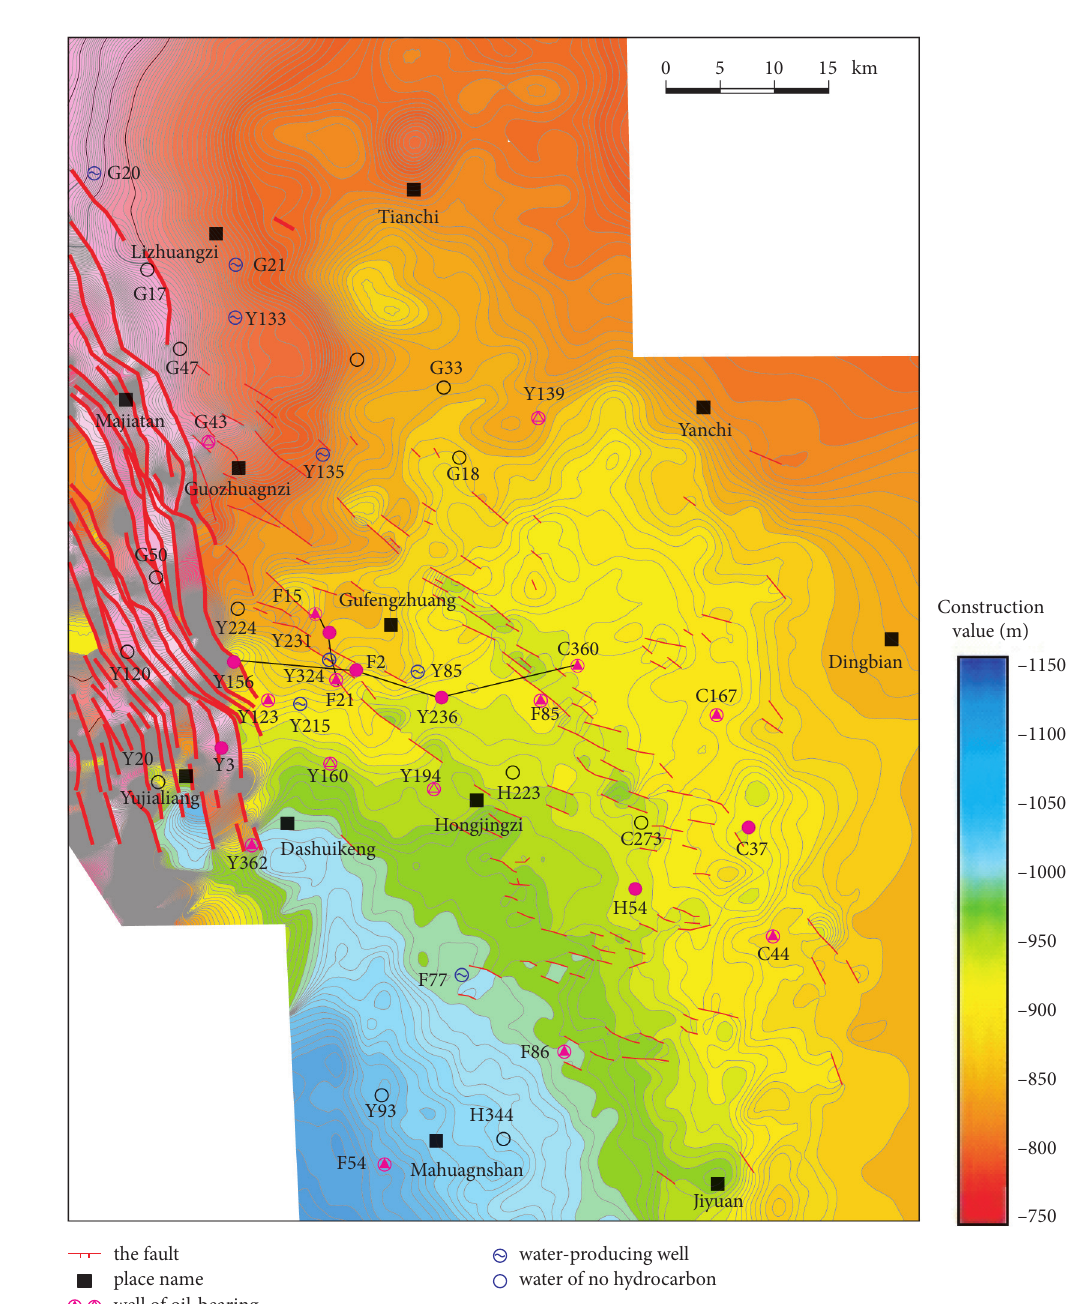
Figure 8: Contour map of the top of the Chang 8 structure of the Yanchang formation in the northwest Ordos